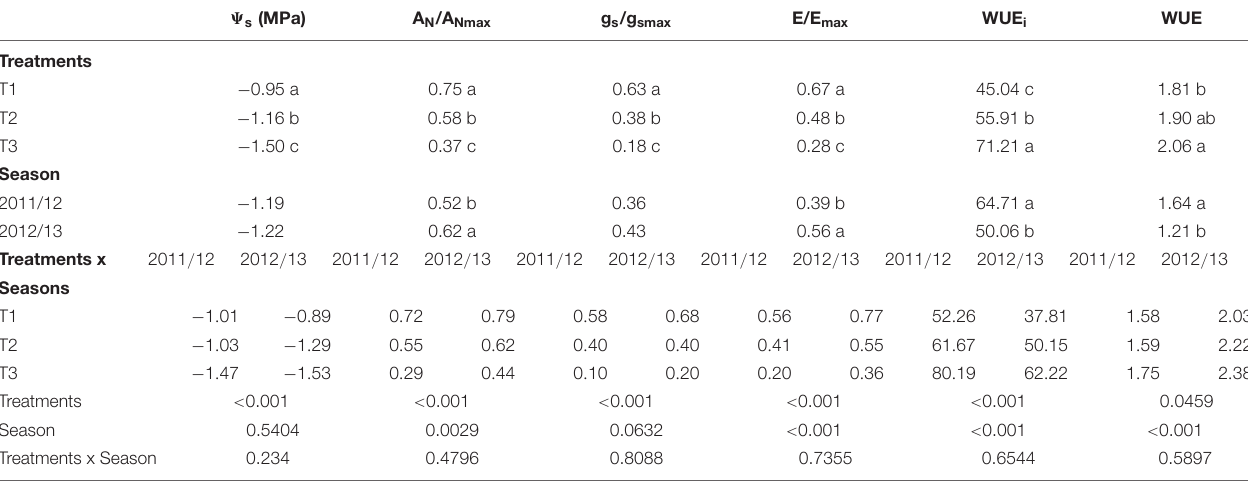
TABLE 5 | Effect of three levels of water application on physiological variables during veraison (V) period of a drip-irrigated Carménère vineyard. (cid:57) s (MPa)